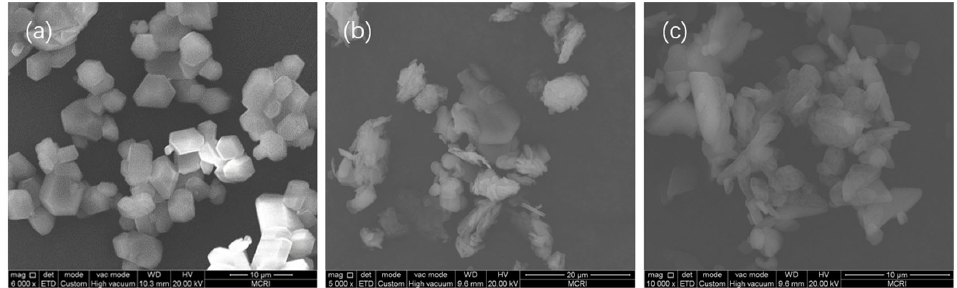
Figure 7. The morphology of HMX in solvents. ( a ) DMSO; ( b ) DMF; ( c ) acetone.